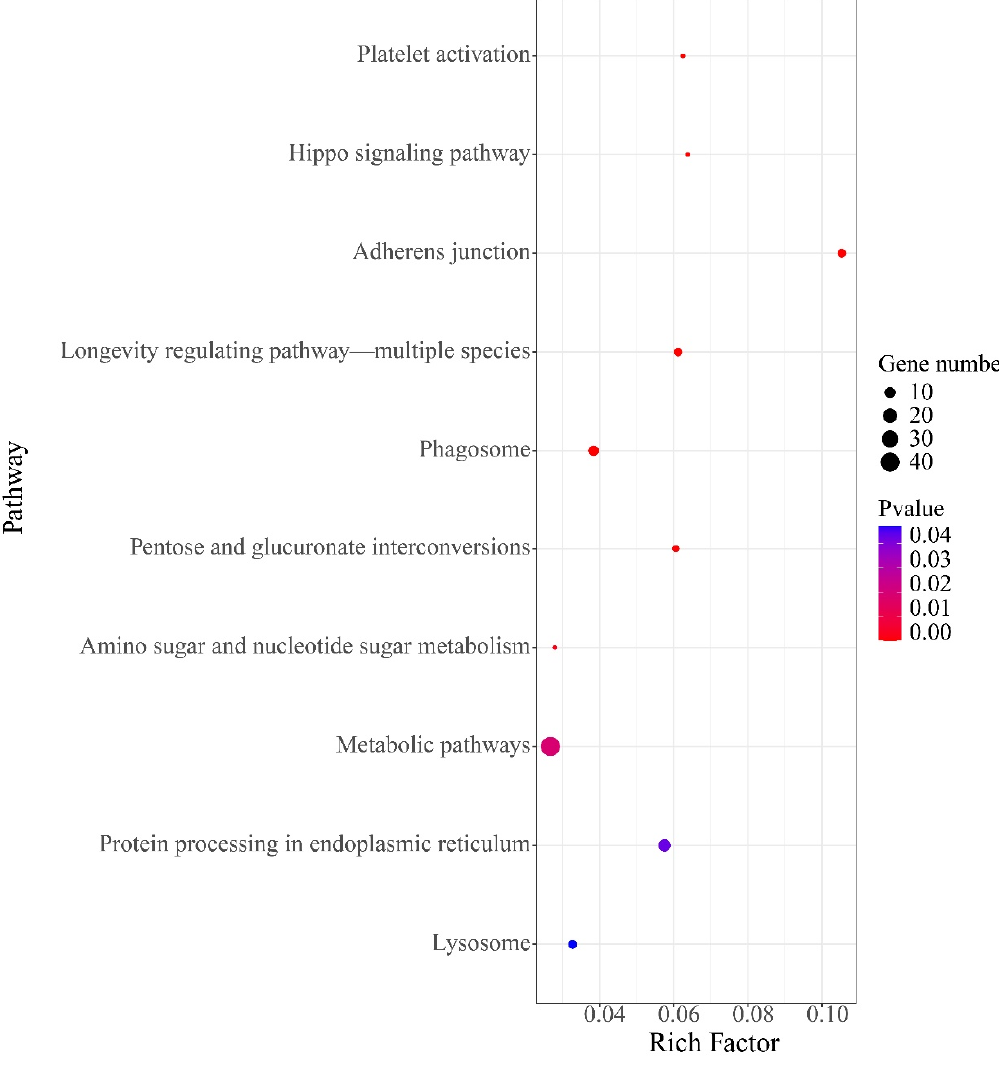
Figure 6. The top 10 KEGG pathways for 566 functional genes (FGs).